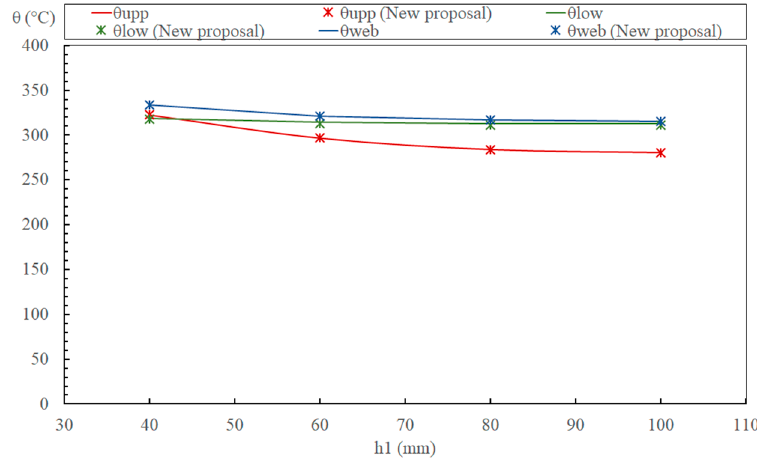
Figure 9. Temperature of the steel deck components for Confraplus 60 under Parametric fire curve 4, for the fire rating period of 60 min. (ANSYS results and new proposal). Table 8. New coefficients proposed to determine the temperature in the rebars under the fire curve Parametric 3.